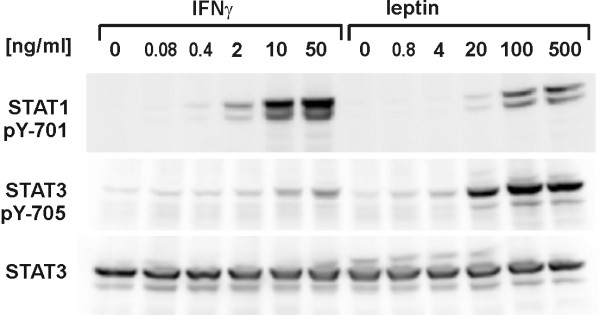
Activation of STAT1 and STAT3 by leptin and IFNγ. RINm5F cells stably expressing LEPRb were stimulated with the indicated concentrations of IFNγ or leptin for 15 min. Tyrosyl phosphorylation of STAT1 and STAT3 was determined by Western blot analysis of total cellular lysates with activation state-specific antibodies. The two bands reacting with the pTyr(705)-STAT1 antibody represent the splice variants STAT1α (91kD) and STAT1β (84 kD). The lower band detected by the STAT3 antibodies is probably the splice variant STAT3β. Total STAT3 immunoreactivity is shown as a control.